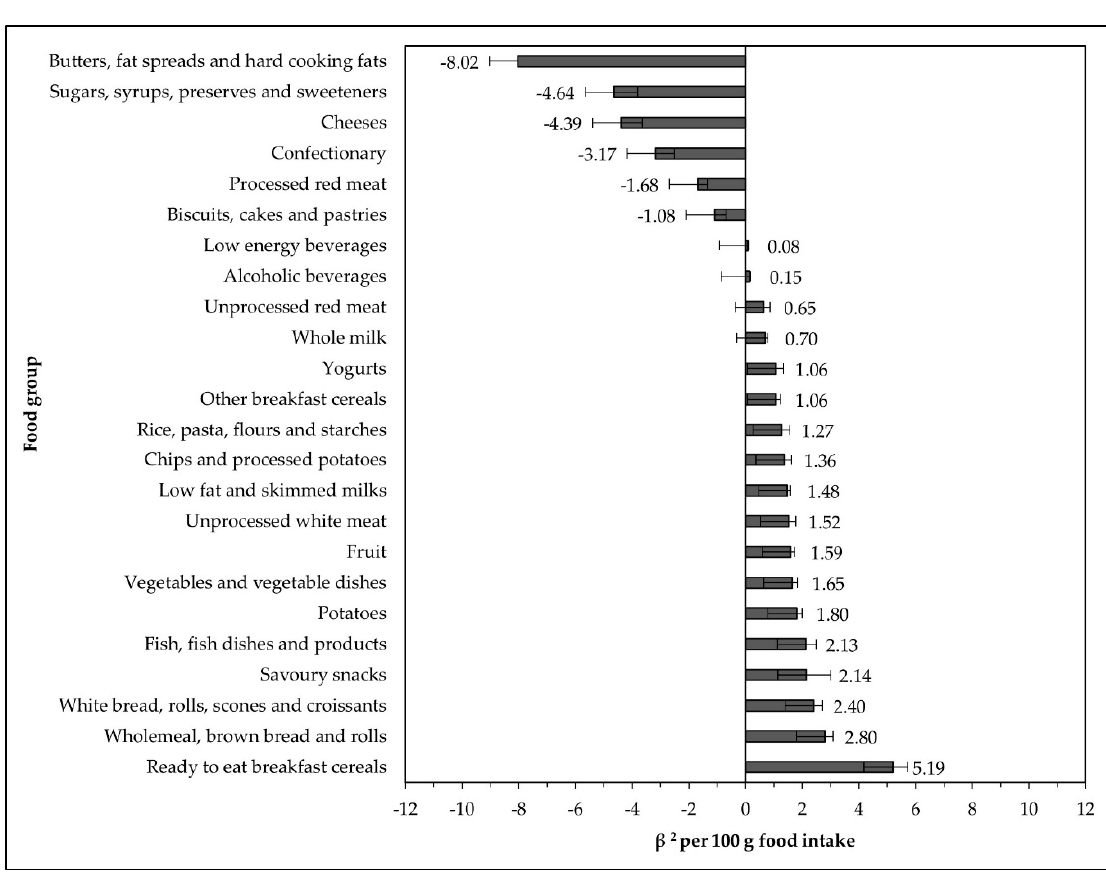
Figure 4. Food group intakes with a significant correlation to PANDiet scores at the population level. Multiple linear regression coefficients corrected for gender, smoking status, and education level. Residual standard error 4.3, error rate 6.8%. R 2 = 0.67, adjusted R 2 = 0.66 F (36 and 992) = 56.67 ( p < 0.0001). Creams, ice-creams, rice puddings, and custard ( β 2 − 0.35); eggs and egg dishes ( β 2 0.51); fruit juices and smoothies ( β 2 0.22); high-energy beverages ( β 2 − 0.01); low-fat spreads and oils ( β 2 1.05); other milks and milk-based beverages ( β 2 0.39); processed white meat ( β 2 0.5); savouries